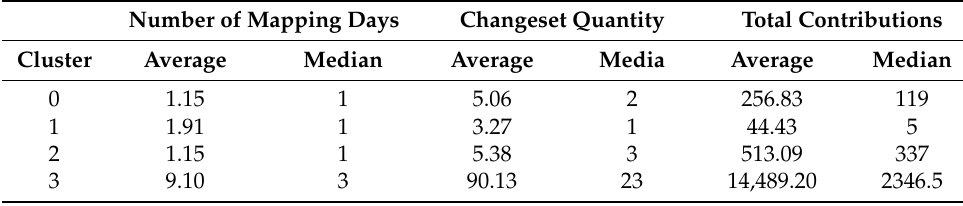
Table 8. Descriptive statistics for each